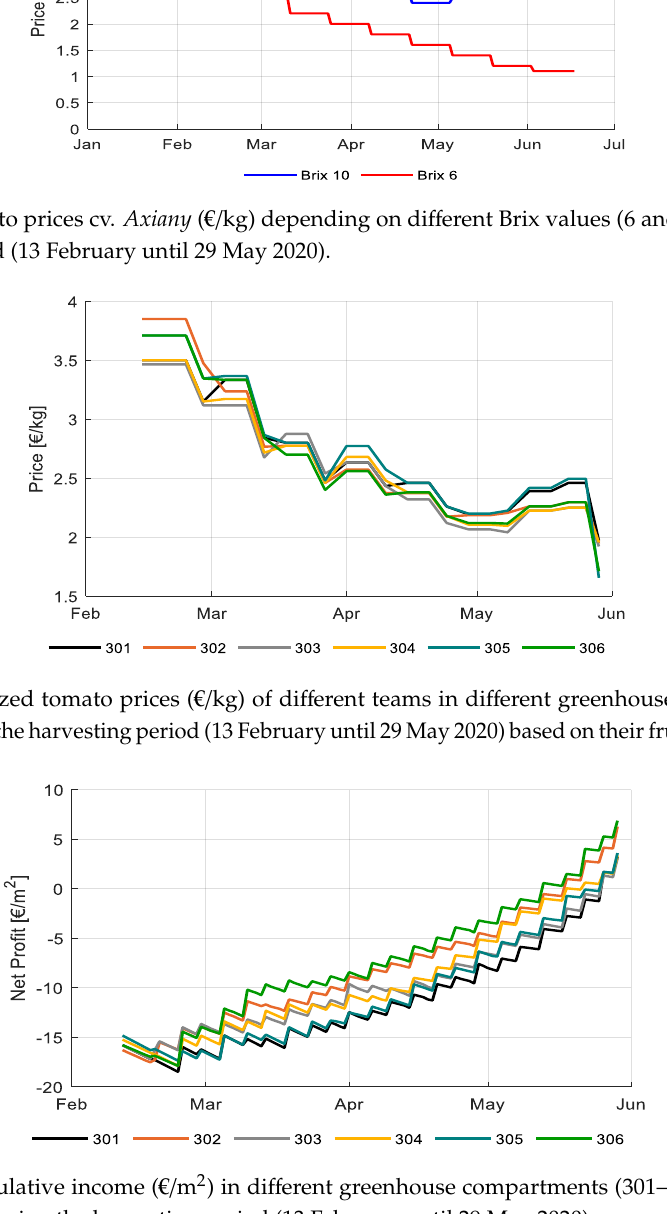
Figure A4. Net profit development (€/m 2 ) realized by different teams in different greenhouse compartments (301-306) during the harvesting period (13 February until 29 May 2020) and total net profit (€/m 2 ).